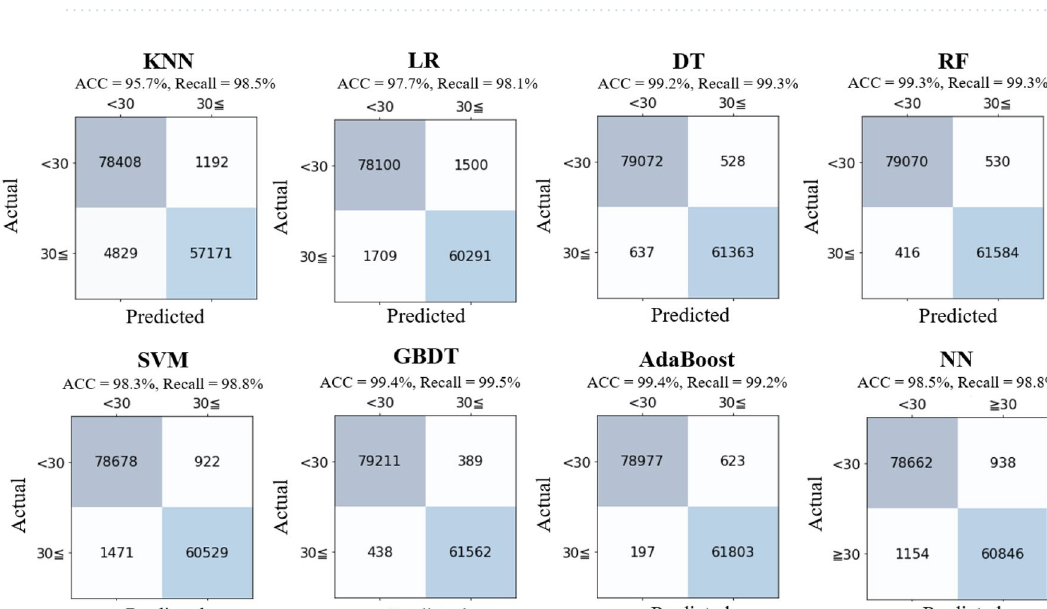
Figure 6. Results of the classification